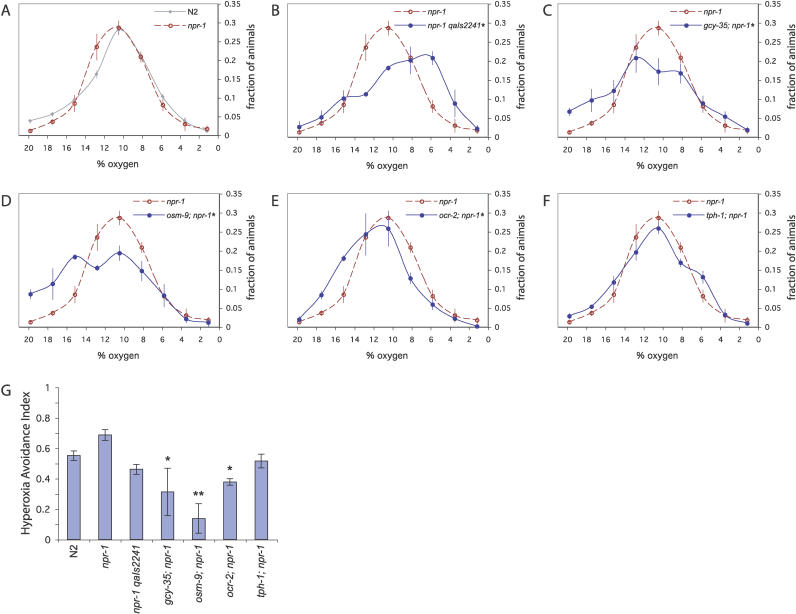
Hyperoxia Avoidance by npr-1 Mutants Requires sGC and TRPV Activity, but not Serotonin(A) Aerotaxis of npr-1 mutants. (B) Aerotaxis of npr-1; qaIs2241 strain. (C) Aerotaxis of gcy-35; npr-1 double mutants. (D) Aerotaxis of osm-9; npr-1 double mutants. (E) Aerotaxis of ocr-2; npr-1 double mutants. (F) Aerotaxis of tph-1; npr-1 double mutants. For (A–F), asterisks denote distributions different by chi-square analysis at p < 0.01 from the first distribution in the panel. n ≥ 3 assays per genotype, 80–100 animals/assay. Error bars denote SEM. For (B–E), all double mutants are significantly different from npr-1 controls, but not significantly different from animals carrying the other mutation (p < 0.01 by chi-square analysis of the complete distribution). (G) Hyperoxia avoidance index as defined in Figure 1. Asterisks and double asterisks, values different from npr-1 controls at p < 0.05 and p < 0.01, respectively, by Dunnett test. Error bars denote SEM.